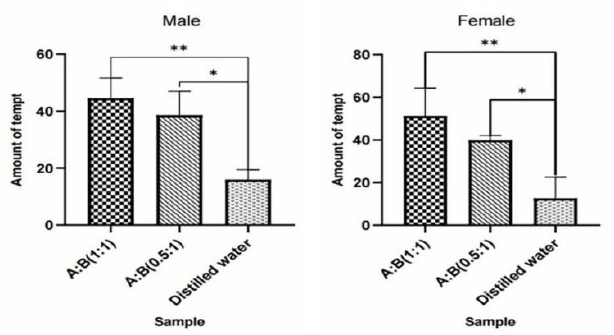
Figure 38. Attractive effects of W. magnifica by mixing methylheptenone and 1-octen-3-ol in different proportions.